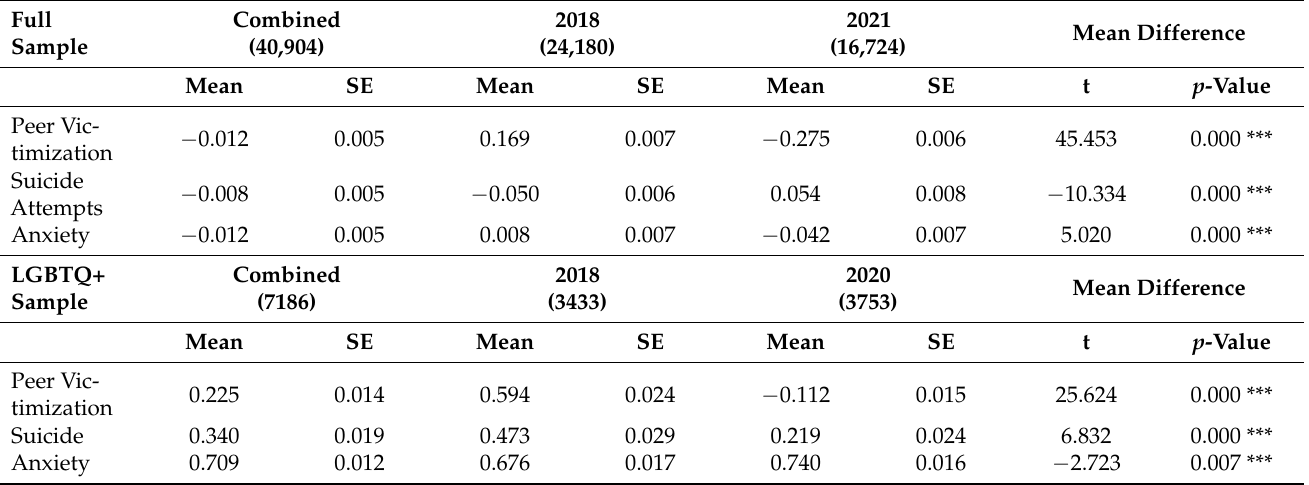
Table 2. Independent sample t -tests comparing rates of peer victimization, anxiety, and suicide before and during the COVID-19 pandemic among LGBTQ+